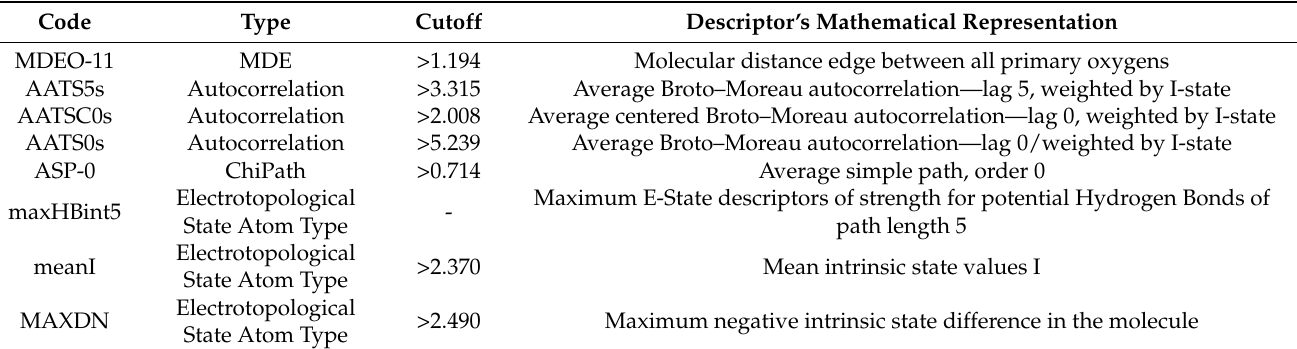
Table 3. List of molecular descriptors capable of identifying the BCI compounds against the DCY structures and their cutoff value for 100%